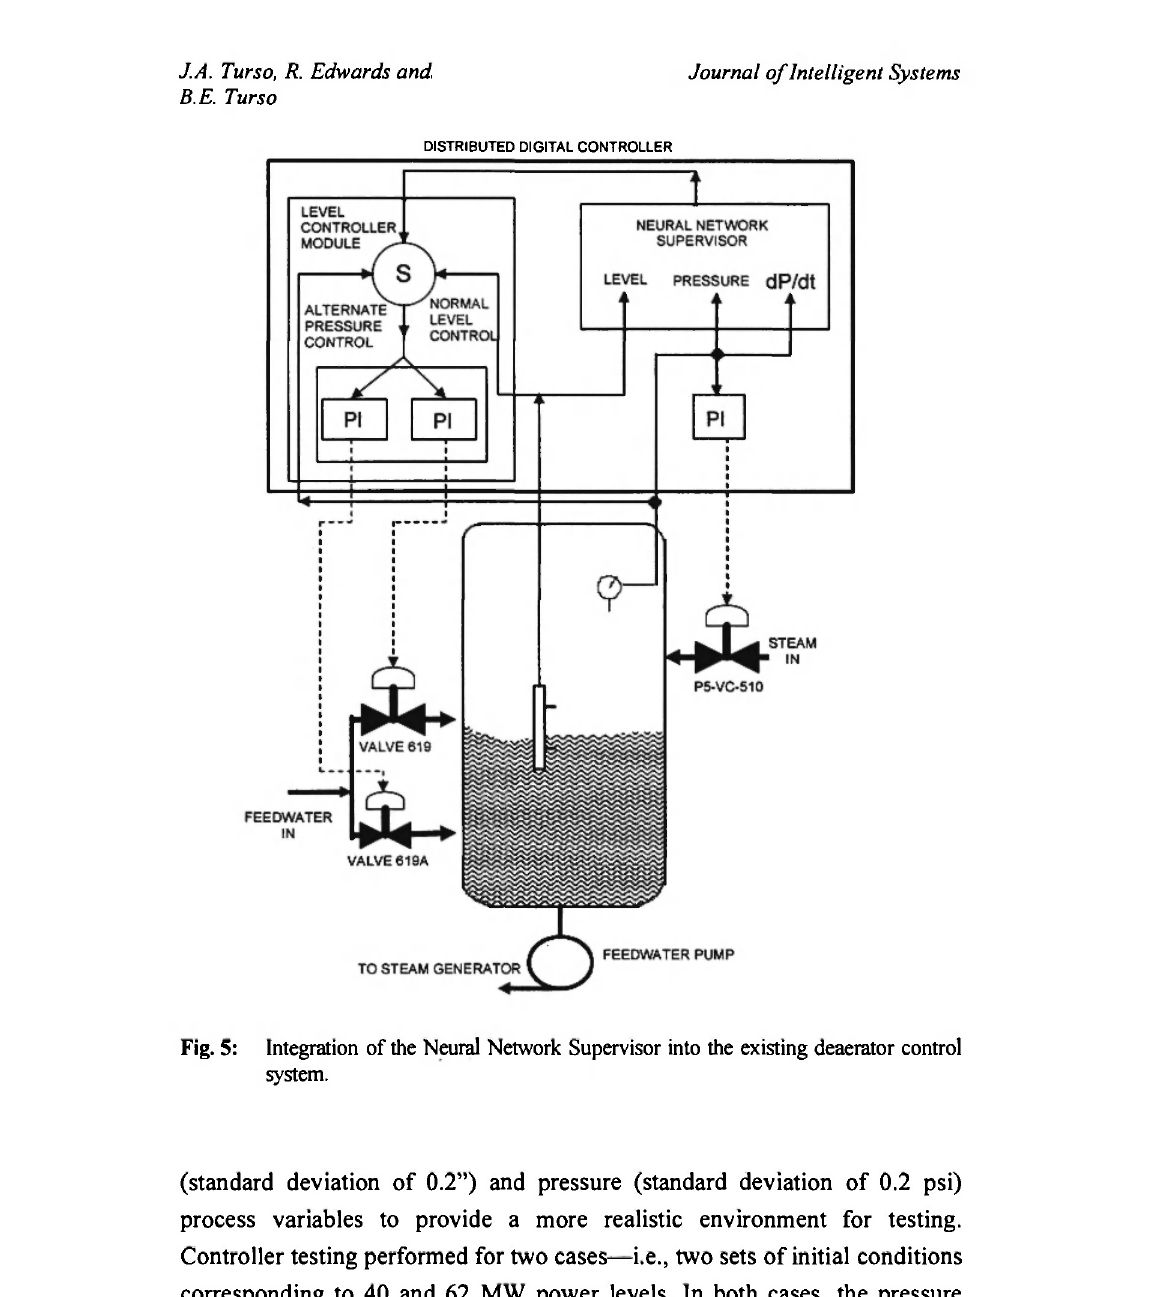
Fig. 5: Integration of the Neural Network Supervisor into the existing deaerator control